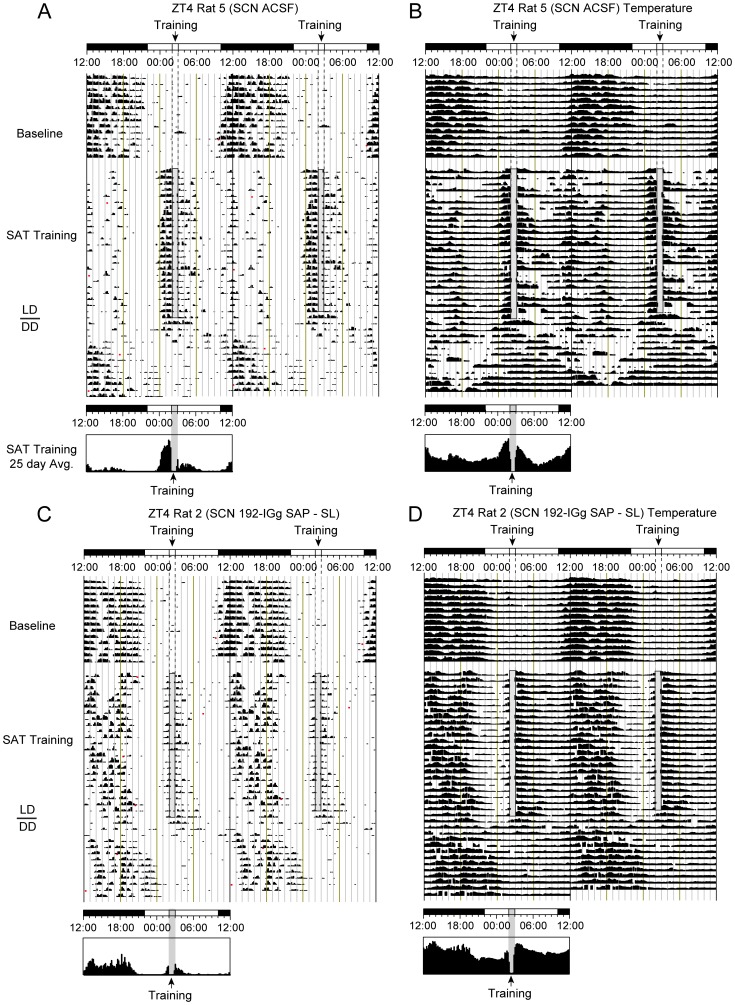
Representative double-plotted running wheel and temperature records for animals training on the Sustained Attention Task (SAT) at ZT4 following ACSF (A&B) or 192 IgG-saporin infusions (C&D) into the SCN.Each line represents 48 hours. SAT training (ZT4) is relative to the topmost LD bar (where dark bar = lights-off). The shaded column represents the task training period where daily water is available including the approximate 40 min SAT session in which animals are absent from their home cages and the 20 minute free water period that follows training. The last day of training corresponded to the final day of LD conditions. Actograms are separated into 2 phases: The first phase represents 14 days of baseline activity prior to SAT training but following ACSF or saporin infusions into the SCN. The second portion of the actogram illustrates the final 25 days of SAT training and the subsequent 14 days of constant conditions (DD). Time histograms below provide 24-hour averages of running wheel activity (A&C) or body temperature (B&D) rhythms for the final 25 days of training shown above. Shaded columns represent time of training. (
A
) Activity and (
B
) temperature record of ZT4 animal with ACSF (control) infusions into the SCN. Note that animal shows a substantial daily anticipation for time of daily training and a primarily diurnal activity pattern. (
C
) Activity and (
D
) temperature record for ZT4 animal with 192 IgG-saporin infusions into the SCN. Daily anticipation is substantially reduced and this animal maintains a primarily nocturnal phenotype. Free-run activity in the lesioned animal, relative to the time training would have occurred, is robustly shorter compared to the control animal.